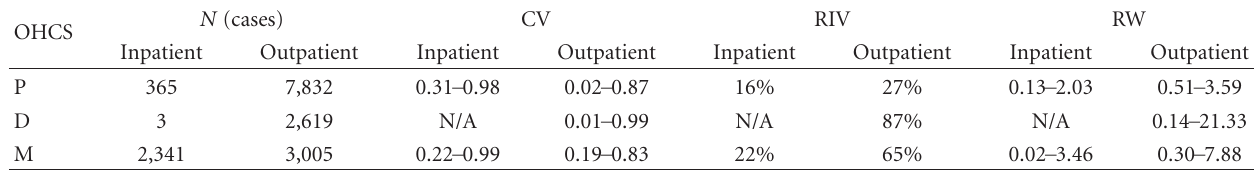
Table 4: Summary of the statistical analysis of the coe ffi cient of variation (CV), reduction in variance (RIV), and relative weight